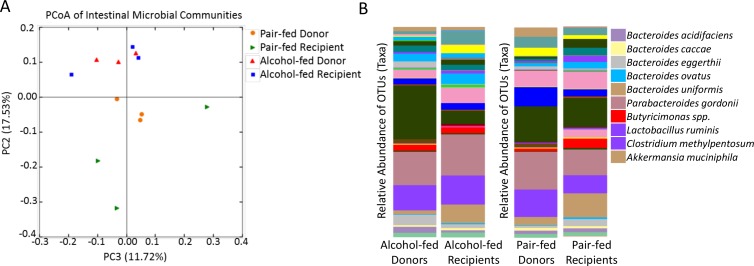
Adoptive transfer maintains microbial community structure.(A) The microbial communities of alcohol-dysbiosis recolonized mice (blue squares) compared to the microbial communities of alcohol-fed donor mice (red triangles), and the microbial communities of pair-fed recolonized mice (green triangles) compared to the microbial communities of pair-fed donor mice (orange circles). (B) Relative abundance of OTUs are similar between alcohol-microbiota recipient and alcohol-microbiota donor animals, as well as pair-fed microbiota recipient and pair-fed microbiota donor animals.